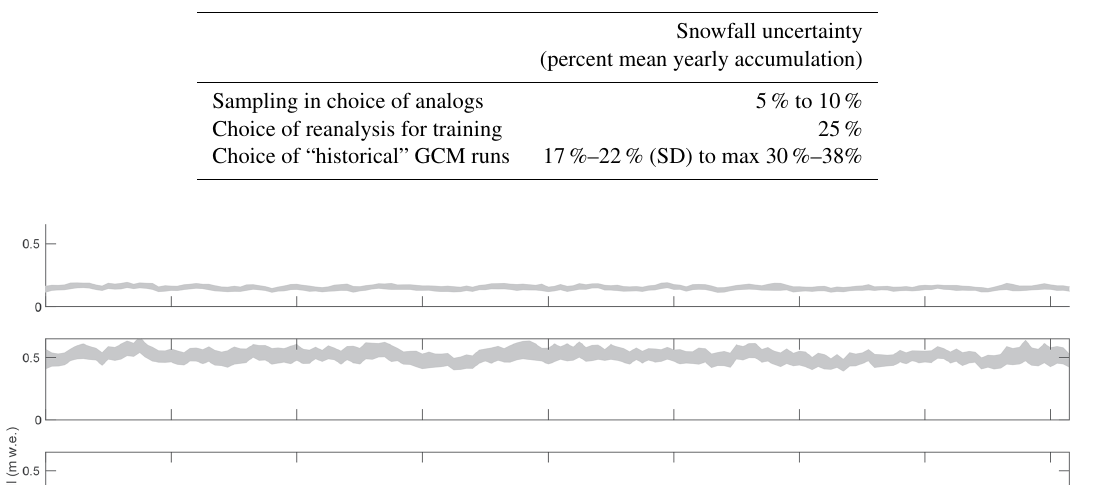
Table 2. Summary of the uncertainty levels associated with the choices of input model or sampling method. The uncertainties (mean uncertainties) are estimated on yearly accumulation of snowfall, relative to the basic methodology followed to derive the database, for at least one time series over the domain.